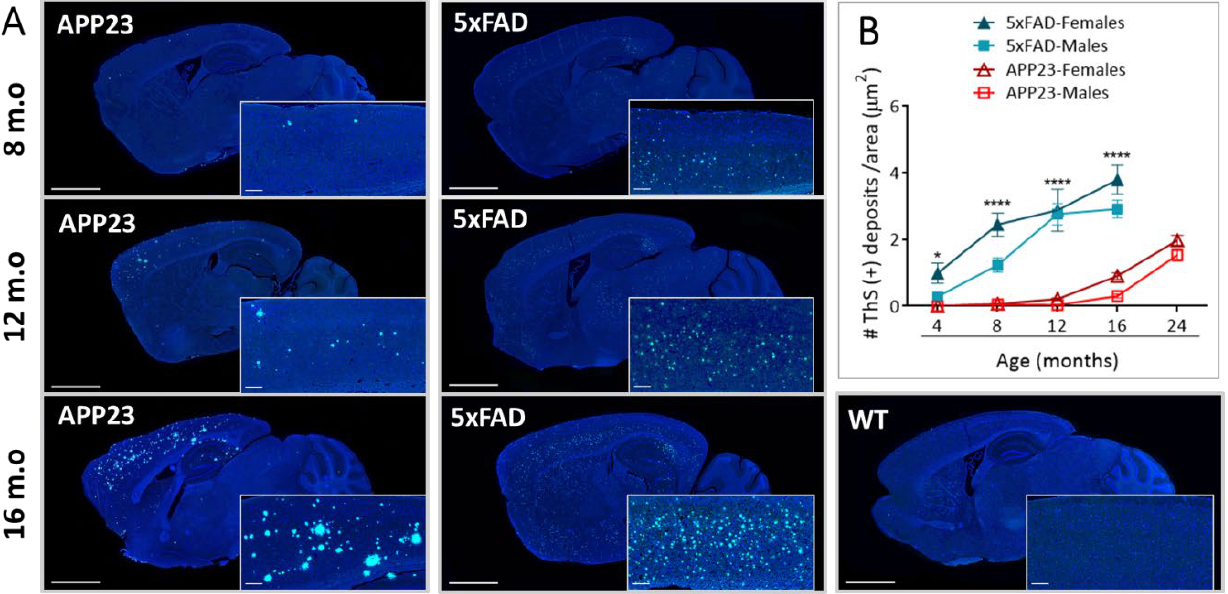
Figure 1. Extracellular A β deposition in 5xFAD and APP23 mice. ( A ) Representative images of sagittal brain sections from female 5xFAD, APP23, and WT mice showing A β -positive fibrillar deposits stained with Thioflavin-S (ThS). Scale bar indicates 2 mm and 200 µ m; m.o: months old. ( B ) Representation of the number of parenchymal A β deposits in male and female 5xFAD mice and APP23 mice at different ages. Data are expressed as the number of ThS-positive deposits (fibrillar A β deposits) per area. n = 4–7/group. Statistical differences were analyzed between APP23 and 5xFAD mice (females + males) and represented as: * p < 0.05, **** p < 0.0001.